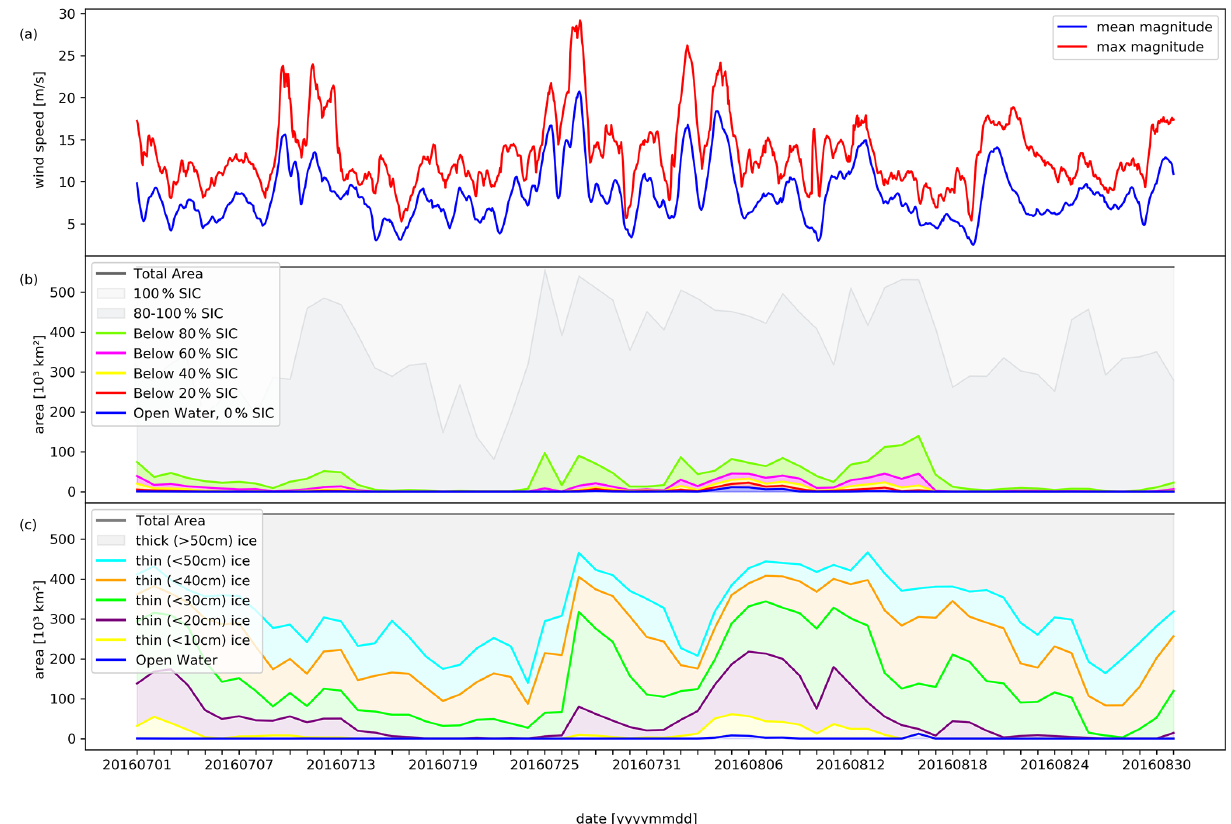
Figure A1. Same format as Fig. 5 for July–August 2016. See Fig. 5 caption for